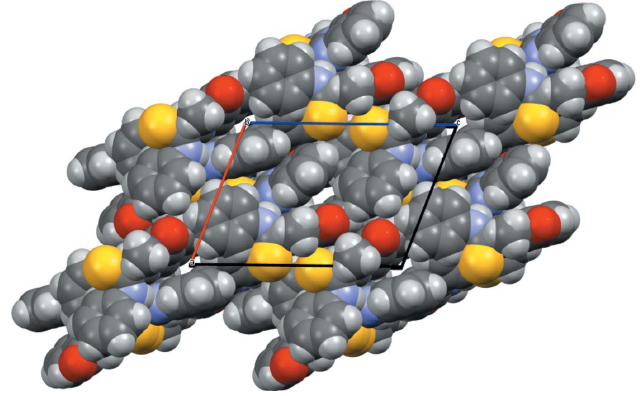
Figure 5 View of the narrow channels formed along the b axis.